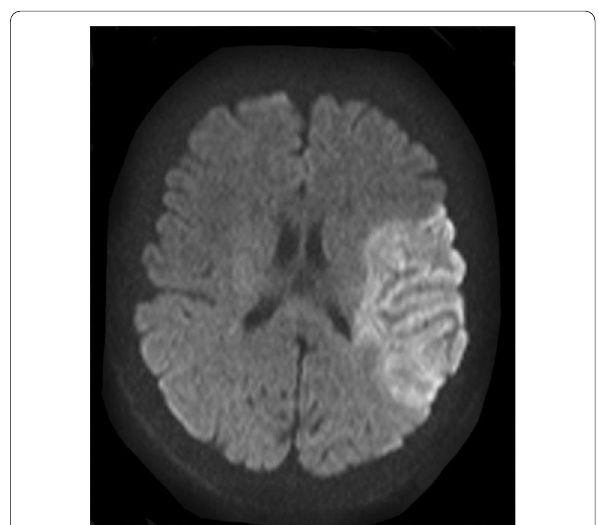
Fig. 1 Magnetic resonance imaging with restricted diffusion representing acute ischemic infarction along dominant language